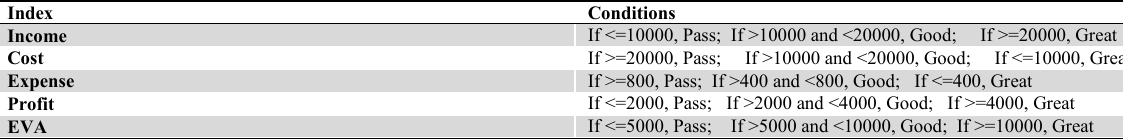
Conditions of Table1